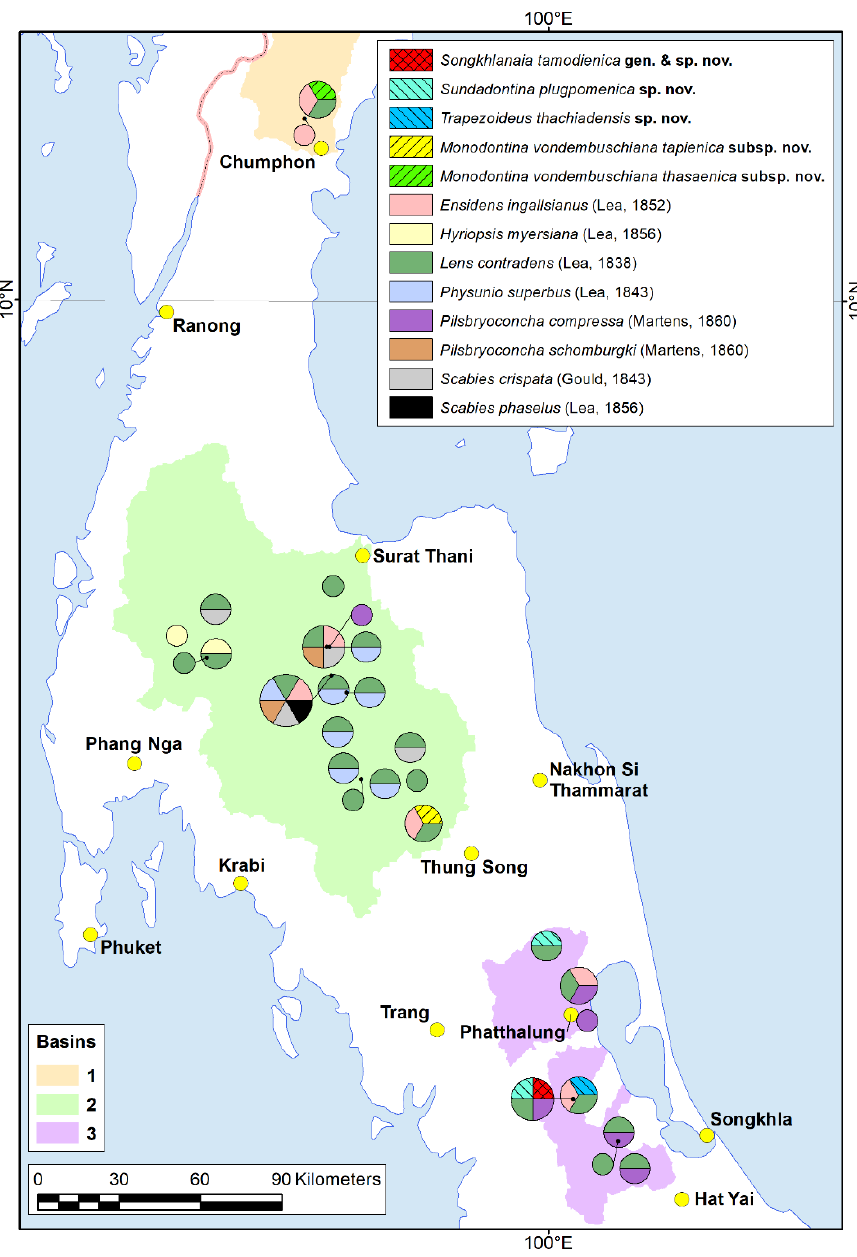
Figure 1. Distribution ranges of Unionidae from Southern Thailand, including the new taxa. The new taxa are marked by corresponding shading and color. The river basins are highlighted in color: 1—Tha Taphao River basin; 2—Tapi River basin; 3—Songkhla Lake basin. The map was created